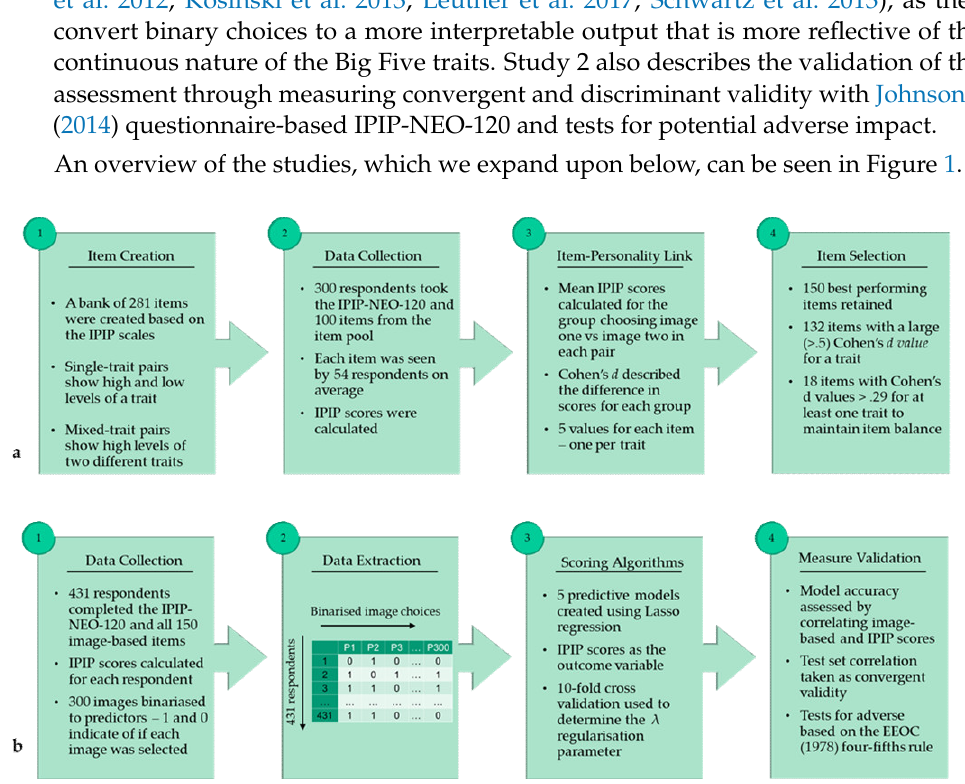
Figure 1. ( a ) Study 1 overview: Item creation and selection of the best-performing items for the image-based Big Five measure. ( b ) Study 2 overview: Creation of scoring algorithms and tests of convergent validity with the questionnaire-based measure and adverse impact.